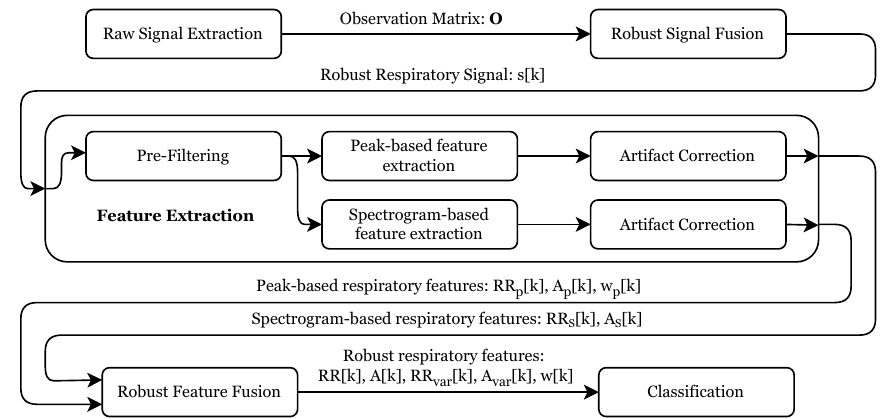
Figure 5. Overview of the complete signal processing algorithm from the raw signal extraction to the breathing pattern